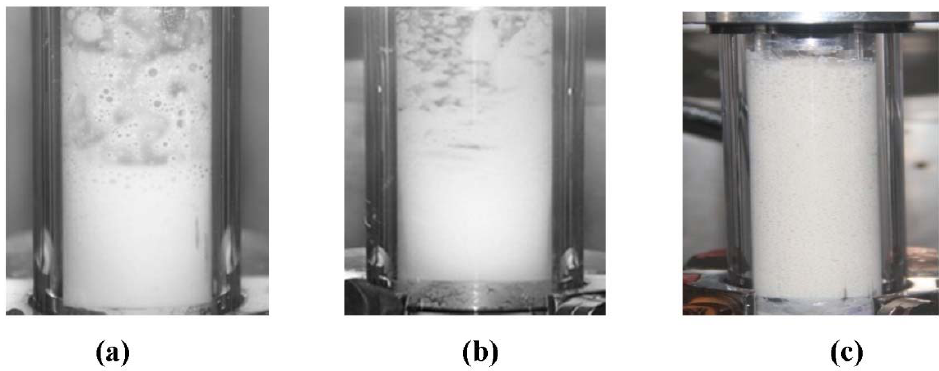
Figure 3. The morphology of the ZIF ‐ 8/water slurry during the separation of a C 3 H 6 /H 2 mixture. ( a ) Fresh ZIF ‐ 8/water slurry; ( b ) separation equilibrium slurry; and ( c ) gas desorption process for ZIF ‐ 8/water slurry.